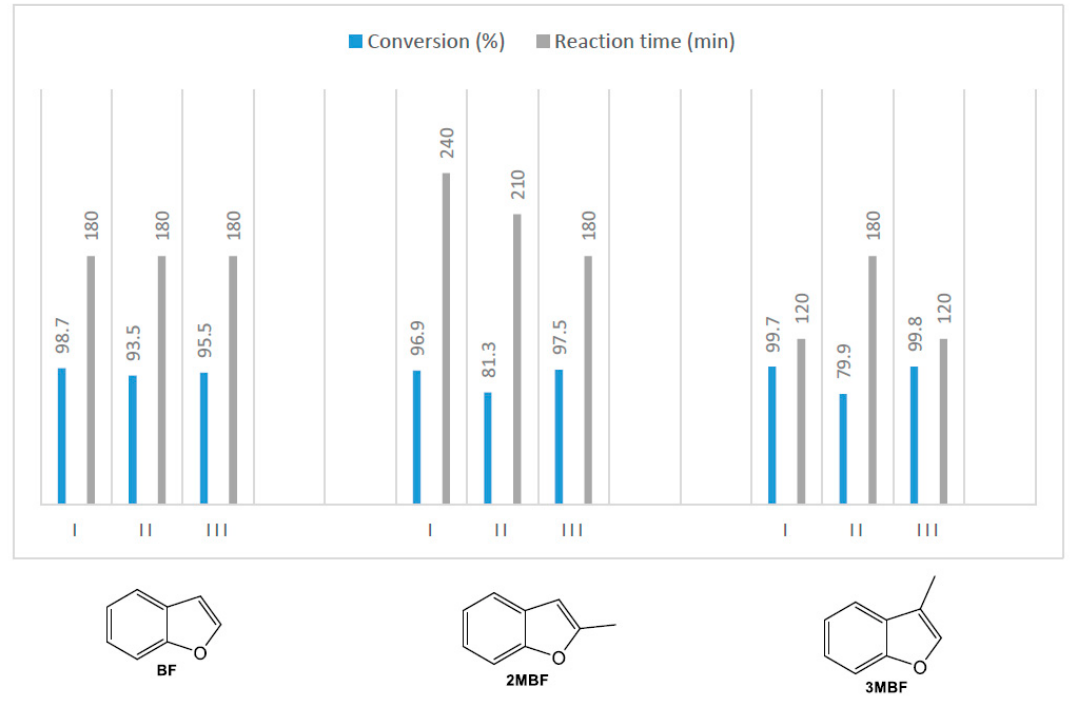
Figure 3. Results of catalytic oxidation of benzofuran ( BF ), 2-methylbenzofuran ( 2MBF ), and 3-methylbenzofuran ( 3MBF ) in the presence of metalloporphyrins ( I – III ) in acetonitrile and using a catalyst loading of 0.3 mol%.